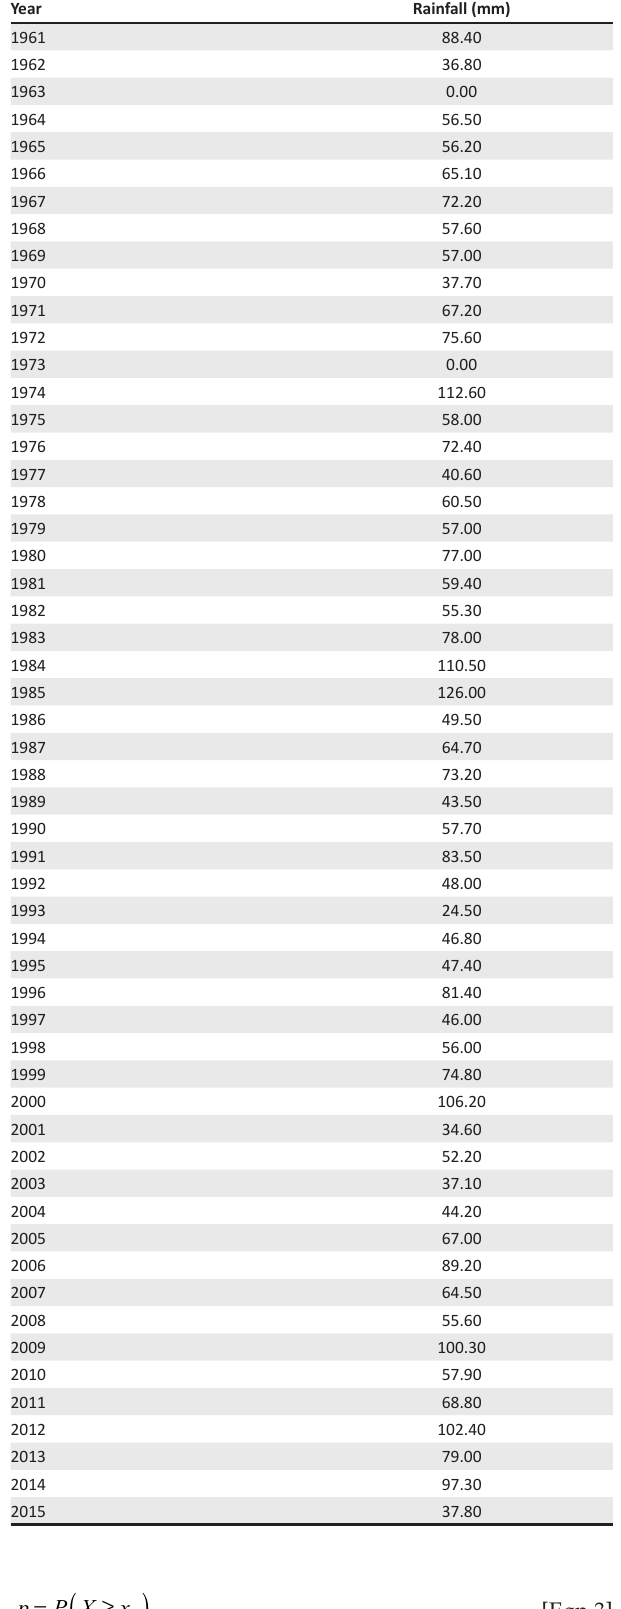
TABLE 1: Annual maximum daily rainfall (mm) events for Nelspruit